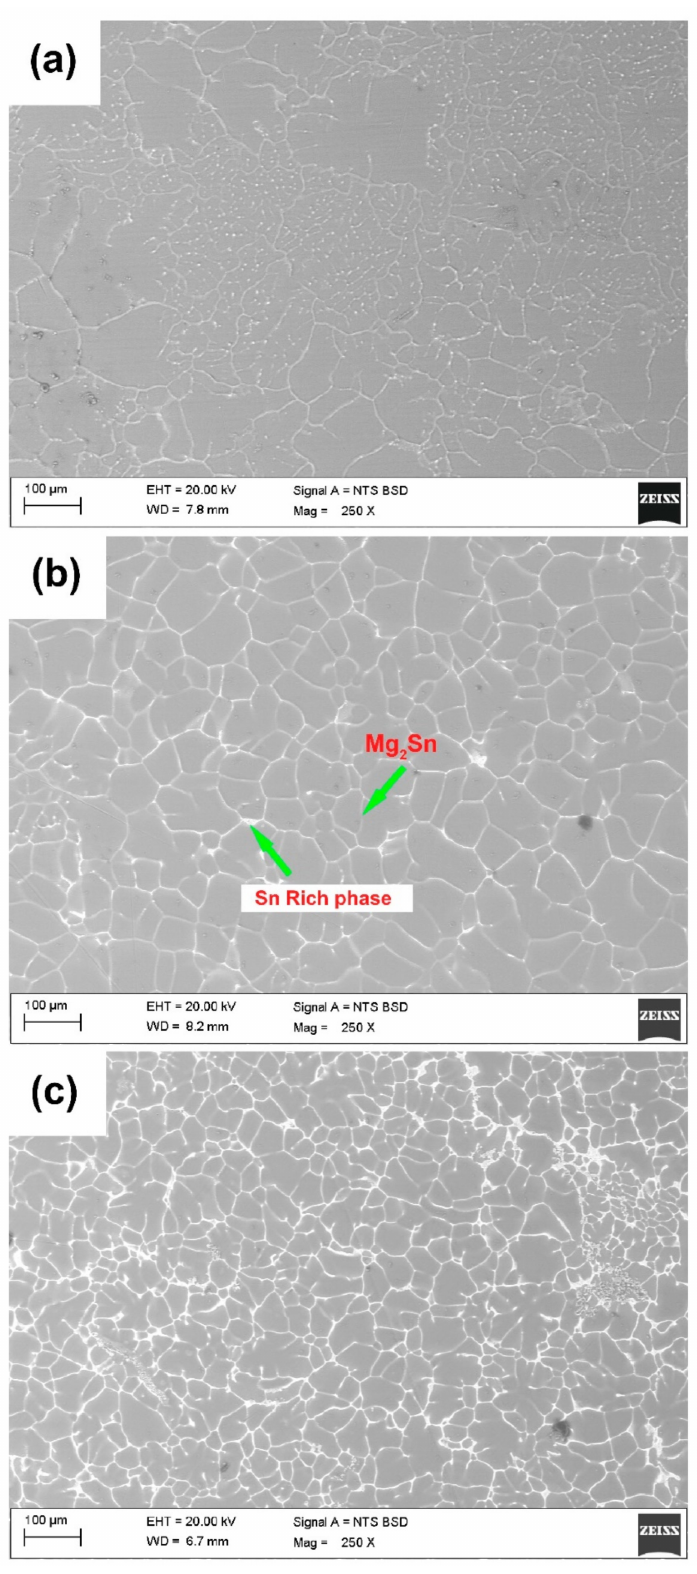
Figure 2. FESEM micrographs of ( a ) Mg-1Sn; ( b ) Mg-5Sn; ( c ) Mg-10Sn alloys. Two major observations can be made from the microstructures of Mg-1Sn, Mg-5Sn, and Mg-10Sn alloys. Firstly, the phase quantity of both Mg 2 Sn and Sn rich area increases with the increase in Sn content in the alloy. Secondly, with the increase in Sn content,